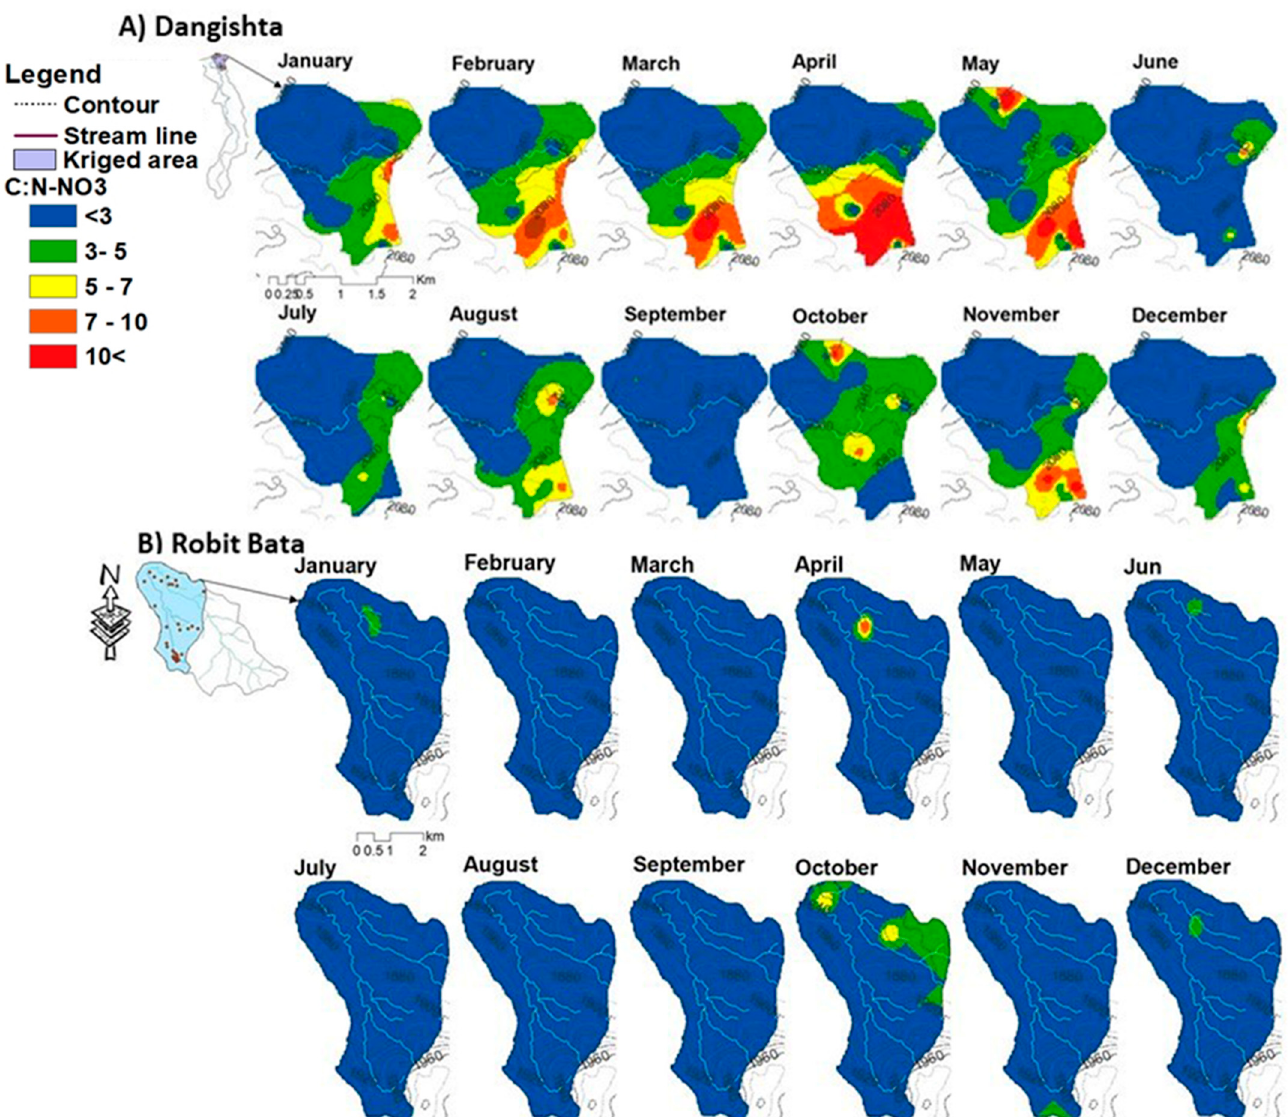
Figure 12. Monthly, two-year-averaged kriged ratio of chloride to nitrate concentration (2017 to 2018) in the aquifers of ( A ) Dangishta and ( B ) Robit Bata watersheds.